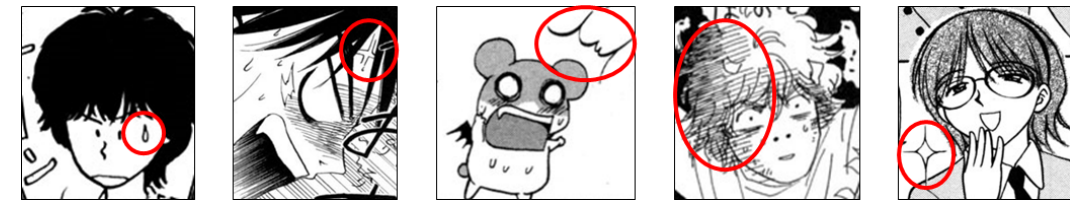
Figure 2. Some examples of “manpu”: a mark used to represent the emotions of the characters such as anger, surprise, embarrassment, confidence, etc. The original images are extracted from the Manga109 dataset [10], c (cid:13) Yoshi Masako, c (cid:13) Kobayashi Yuki, c (cid:13) Arai Satoshi, c (cid:13) Okuda Momoko, c (cid:13) Yagami Ken.